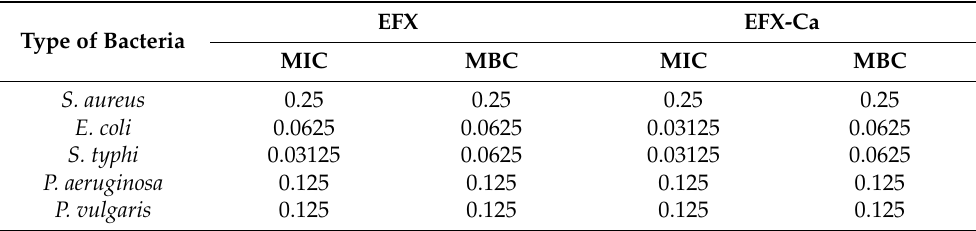
Table 2. The antibacterial activity against five bacteria of EFX and EFX-Ca shown as MIC and MBC values ( µ